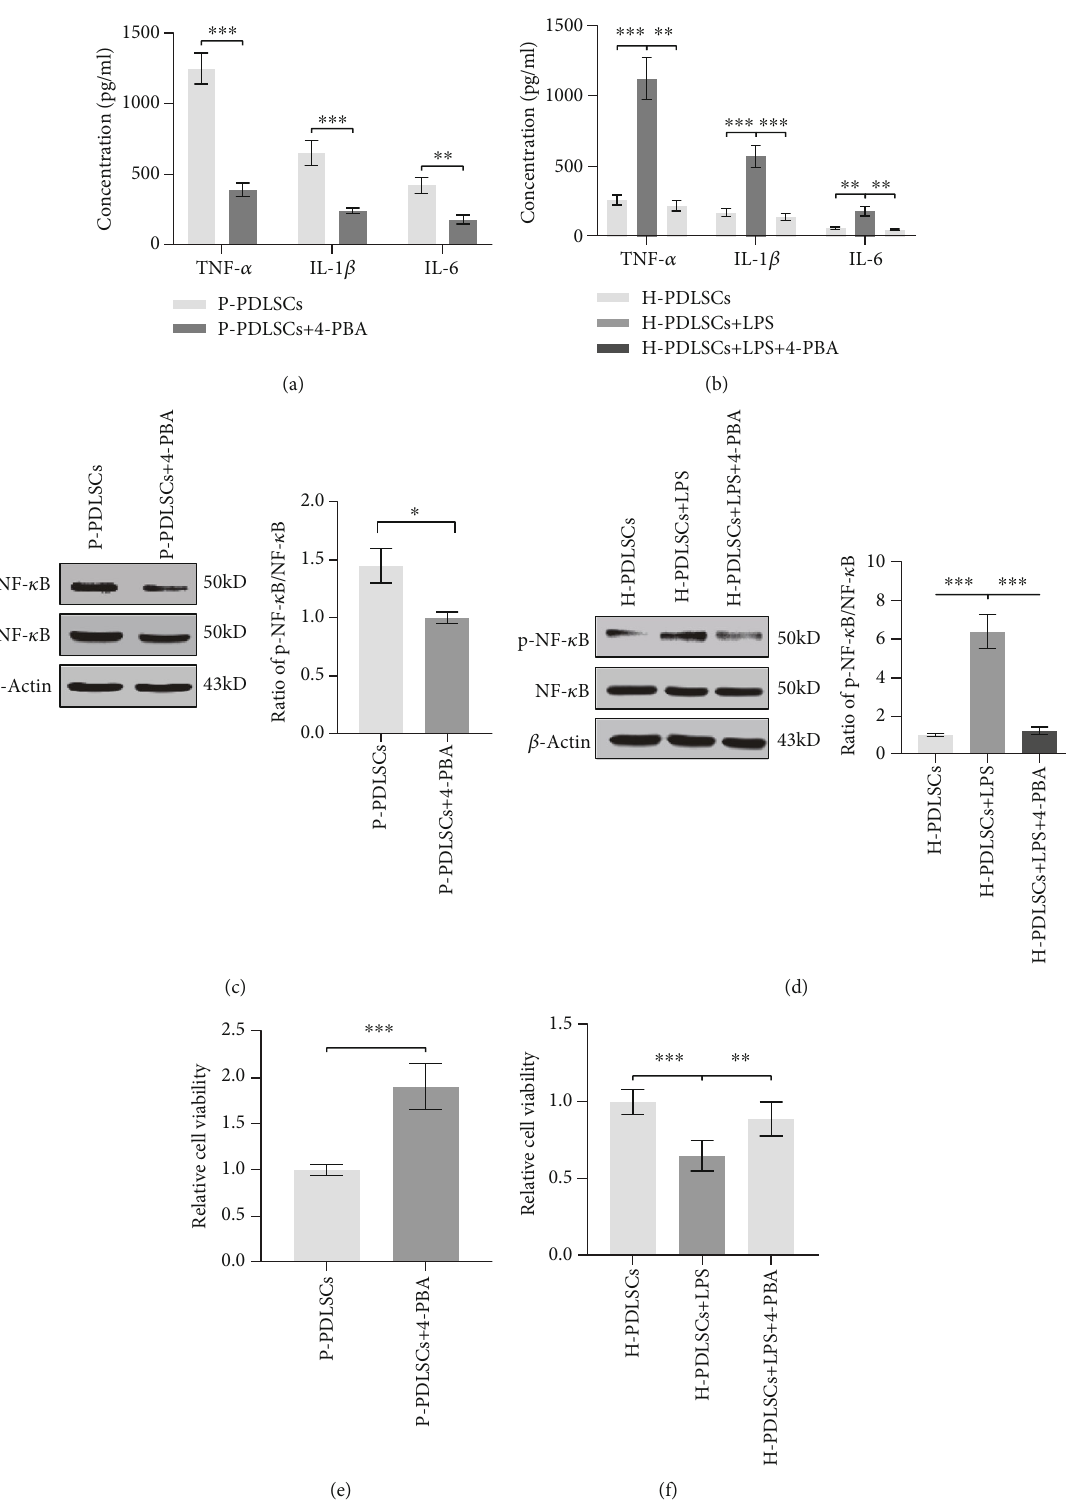
Figure 2: 4-PBA attenuates in fl ammatory response of P-PDLSCs and LPS-treated H-PDLSCs. The secretion of proin fl ammatory factors TNF- α , IL-1 β , and IL-6 was detected by using ELISA in (a) P-PDLSCs treated without or with 5mM 4-PBA and (b) H-PDLSCs treated in the absence or presence of 10mg/l LPS or LPS in association with 5mM 4-PBA. Western blot analysis showed the expression levels of p-NF- κ B and NF- κ B, as well as the ratio of p-NF- κ B/NF- κ B in (c) P-PDLSCs treated without or with 5mM 4-PBA or in (d) H-PDLSCs treated in the absence or presence of 10mg/l LPS or LPS in association with 5mM 4-PBA. Internal control used β -actin. (e, f) Cell viability was determined by using CCK-8 assay after two days treatment. The data represent mean ± standard deviations ( n = 3 ). ∗ P < 0 : 05 , ∗∗ P < 0 : 01 , ∗∗∗ P < 0 : 001